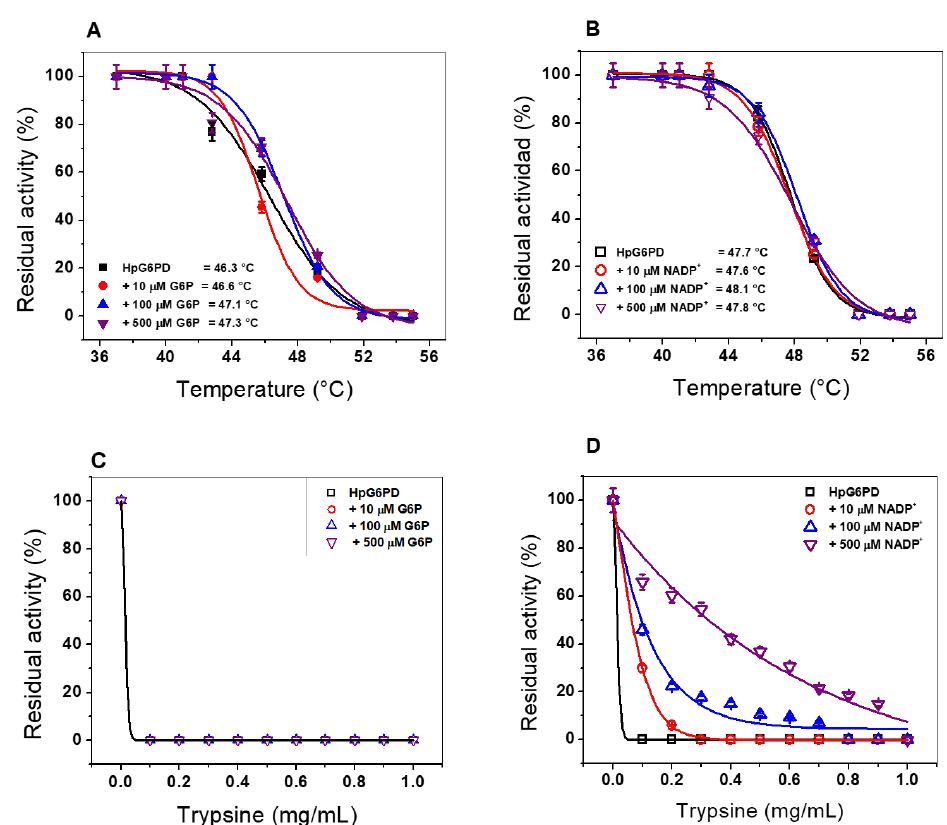
Figure 6. Evaluation of the stability of the HpG6PD protein, via a thermal inactivation assay in the absence and presence of different concentrations of G6P ( A ) and NADP + ( B ). ( C ) Digestion of the recombinant HpG6PD protein with different concentrations of trypsin (0 to 1 mg/mL), in the presence of three concentrations of G6P (10, 100, and 500 μM) and ( D ) NADP + (10, 100, and 500 μM). In all the assays, the protein was adjusted to a concentration of 0.2 mg/mL in phosphate buffer, pH 7.35, and was incubated for 2 h at 37 °C, after which the residual activity was measured. The assay was initiated with the addition of 1 µg of total protein. Data are presented as mean values ± SEM of 3 independent experiments.